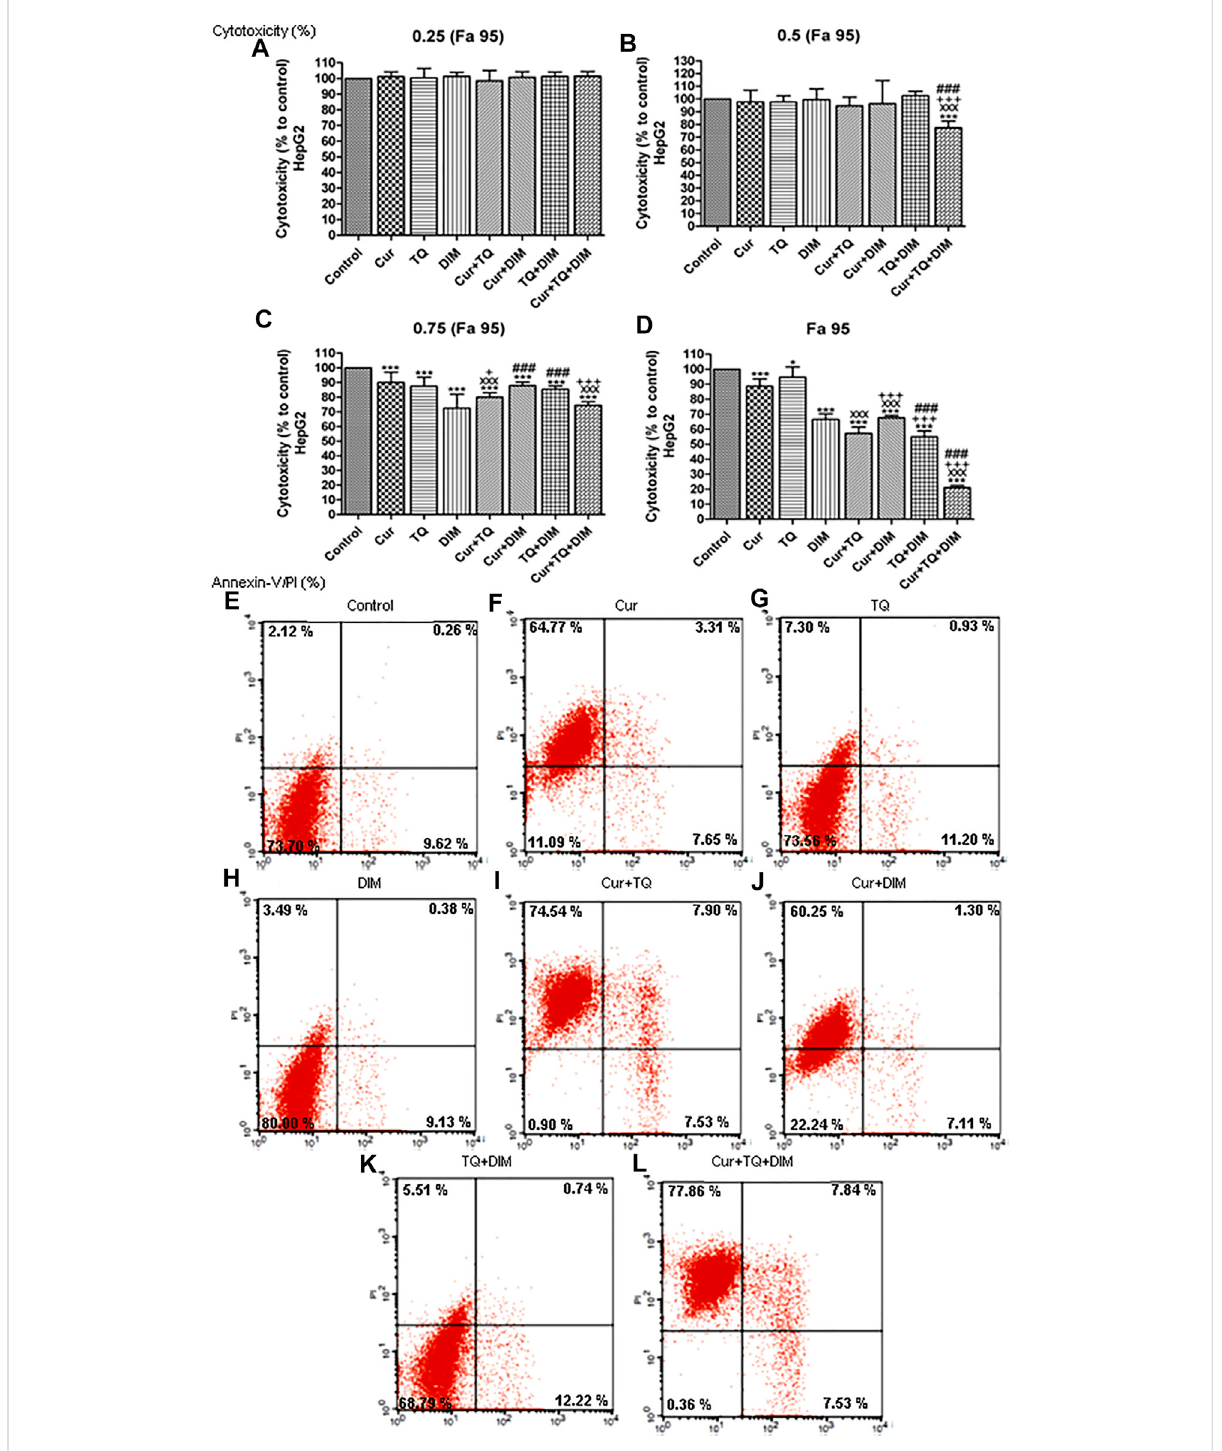
FIGURE 6 Cytotoxicityand annexin-V positivecell percentagesofHepG2. (A) Cytotoxicity percentages of0.25 (Fa95) (B) 0.50(Fa95) (C) 0.75(Fa95),and (D) Fa 95 of curcumin (Cur), thymoquinone(TQ),and 3,3 ′ -diindolylmethane (DIM) againstHepG2. (E) Annexin-V positive cell percentages of control HepG2 cells. (F) Cur-treated cells with 0.75 (Fa 95) = 15.83 µM. (G) TQ-treated cells with 0.75 (Fa 95) = 18.71 µM. (H) DIM-treated cells with 0.75 (Fa 95) = 42.27 µM. (I) Cur + TQ treated cells with 0.75 (Fa 95) of Cur and TQ. (J) Cur + DIM treated cells with 0.75 (Fa 95) of Cur and DIM. (K) TQ + DIMtreatedcellswith0.75(Fa95)ofTQandDIM. (L) Cur+TQ+DIMtreatedcellswith0.75(Fa95)ofCur,TQ,andDIM.Thedatawereanalyzedwith one-way ANOVA followed by Tukey ’ s multiple comparison test. Error bars represent mean ± SD. * p < 0.05 and *** p < 0.001 vs. control. xxx P < 0.001 vs. Cur. + p < 0.05 and +++ p < 0.001 vs. TQ. ### p < 0.001 vs.